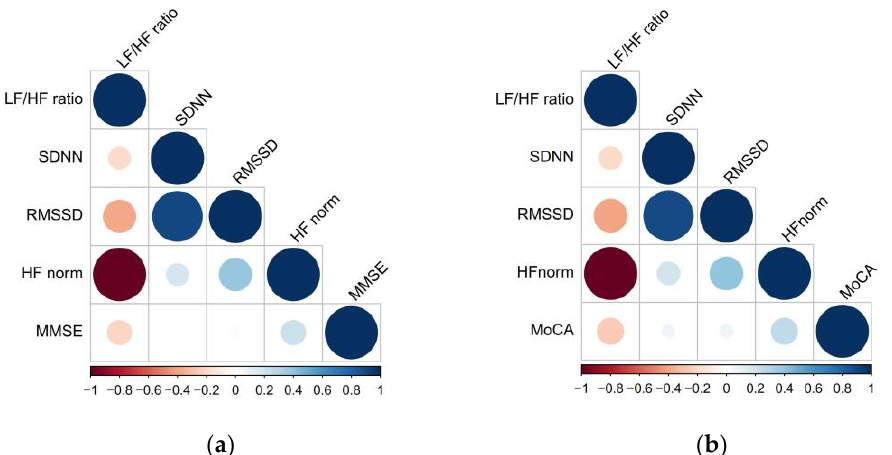
Figure 1. Spearman correlation between HRV parameters and MMSE and MoCA scores among patients with CSVD. ( a ). Spearman correlation between HRV parameters and MMSE scores. ( b ) Spearman correlation between HRV parameters and MoCA scores. CSVD, cerebral small vessel disease; HF, high frequency; HRV, heart rate variability; LF, low frequency; MMSE, Mini-Mental-State Examination; MoCA, Montreal Cognitive Assessment; RMSSD, root mean squares of successive differences of normal/normal intervals; SDNN, standard deviation of the normal/normal intervals.